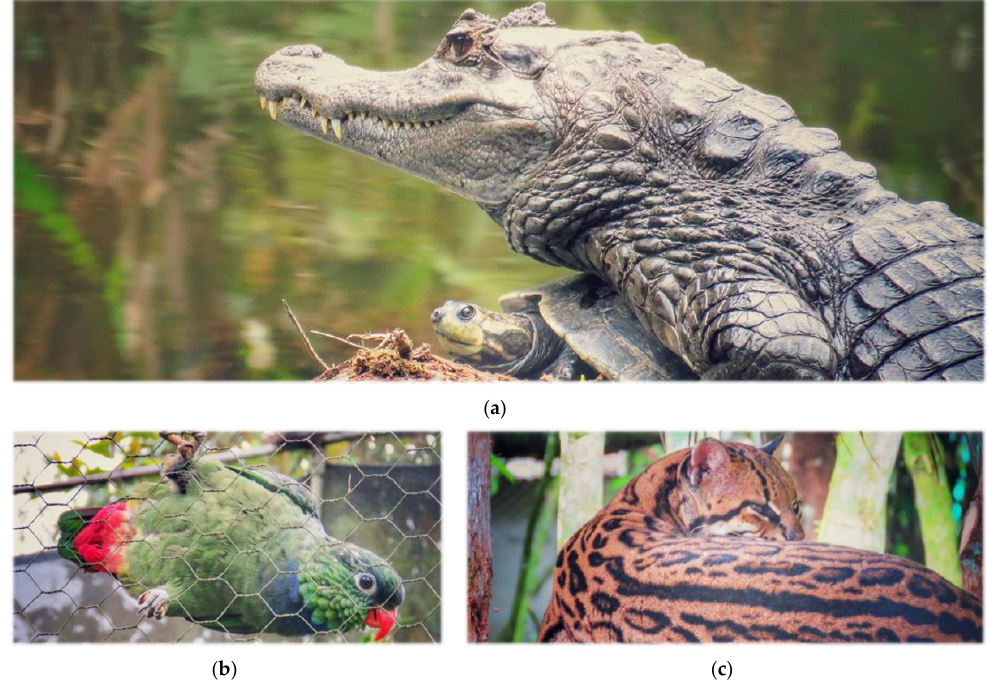
Figure 3. Tamandua Wildlife Sanctuary, YanaCocha Rescue Center, species in captive rehabilitation: ( a ) Spectacled caiman ( Caiman crocodilus ) and giant river turtle ( Podocnemus expansa ); ( b ) Red-billed parrot ( Pionus sordidus ). Parrots are one of the major targets of illegal pet trade in Ecuador; ( c ) Globally decreasing ocelot ( Leopardus pardalis